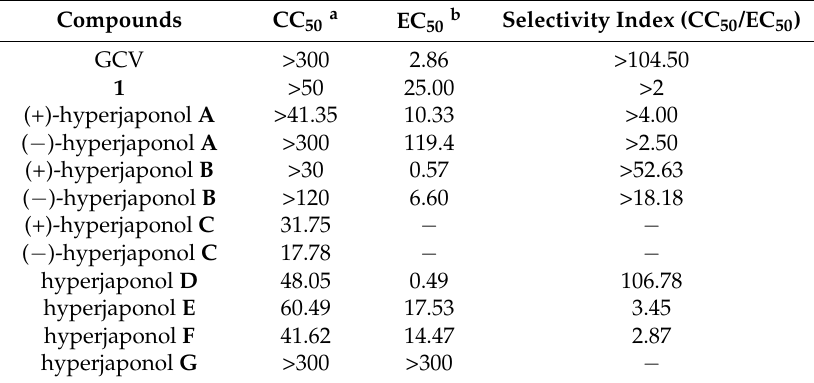
Table 2. Anti-EBV activities of positive control ganciclovir (GCV), 1 , and the reported compounds (hyperjaponols A – G ) ( µ M).